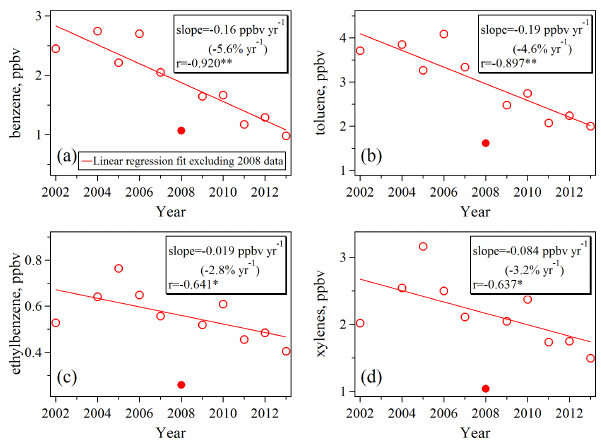
Figure 6. Temporal changes in ambient levels for (a) benzene, (b) toluene, (c) ethylbenzene, and (d) xylenes measured at the PKU site during August from 2002 to 2013. The solid red lines represent linear regression fits for aromatics levels during August from 2012 to 2013 excluding data for August 2008 (the red filled circle).